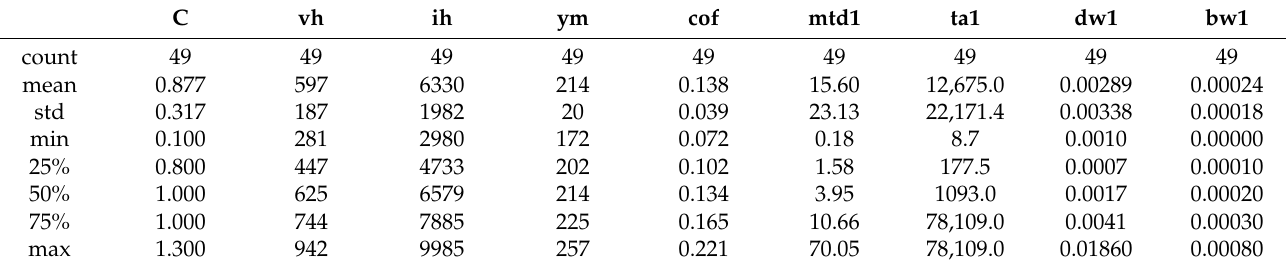
Table 6. Basic information for the set—dry friction.